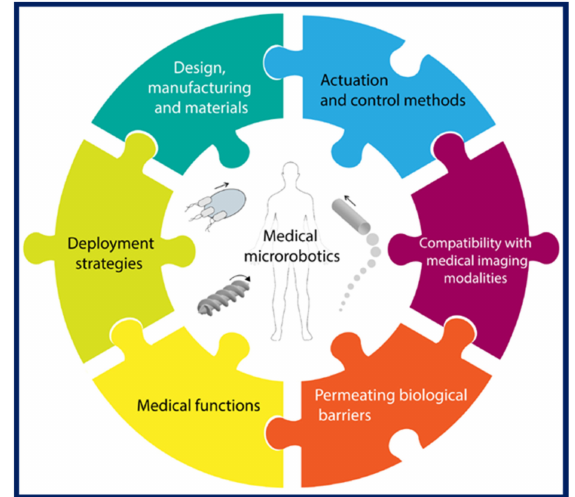
Figure 9. Essential considerations for biomedical microswimmers for in vivo applications, according to Ceylan et al. [119]. Figure reproduced from [119], © 2019 by the authors (Creative Commons Attribution